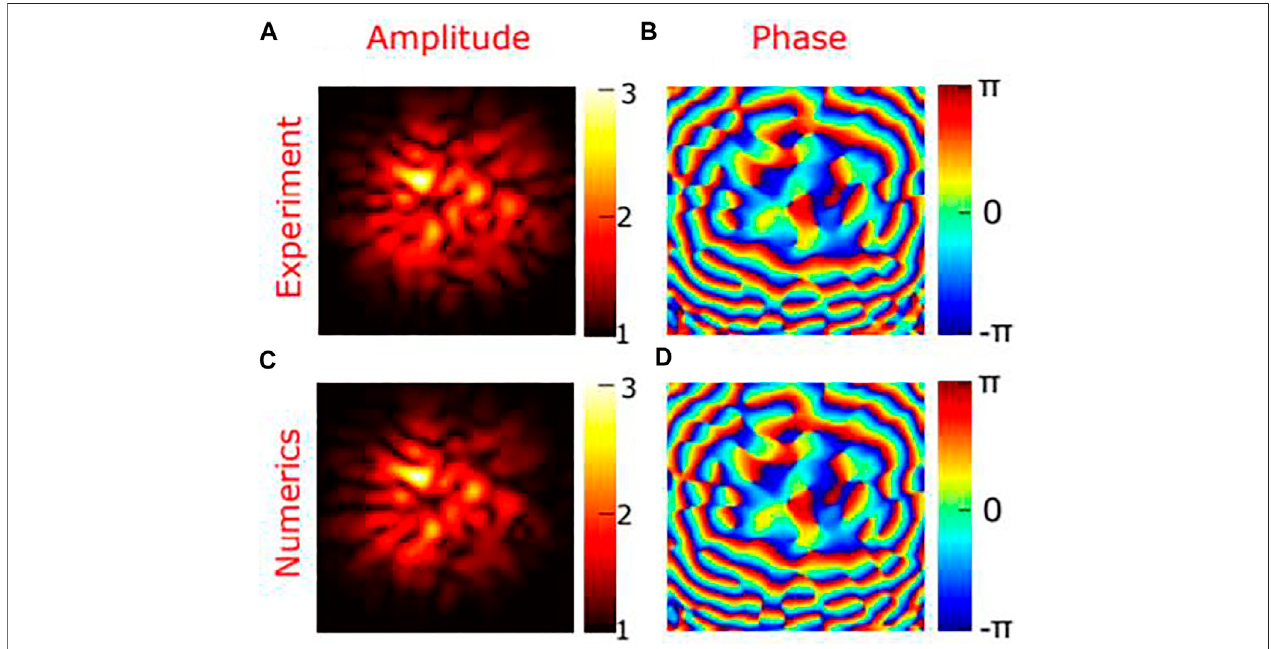
FIGURE 4 | Comparison of a numerical simulation with experiment for fi ber in the presence of mode coupling.